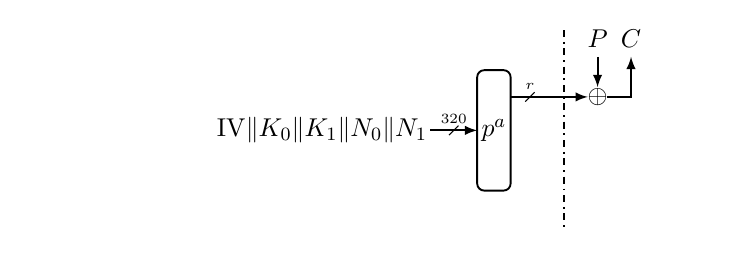
Figure 7: Our attack